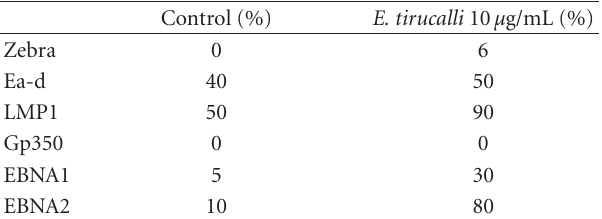
Table 2: Immunocytochemistry (ICC) of EBV-encoded proteins in cells treated with E. tirucalli at the concentration of 10 μ g/mL versus untreated cells, expressed as percentage of positive cells out of total cells. Comparable results were obtained in LCL and cord blood- derived cells.